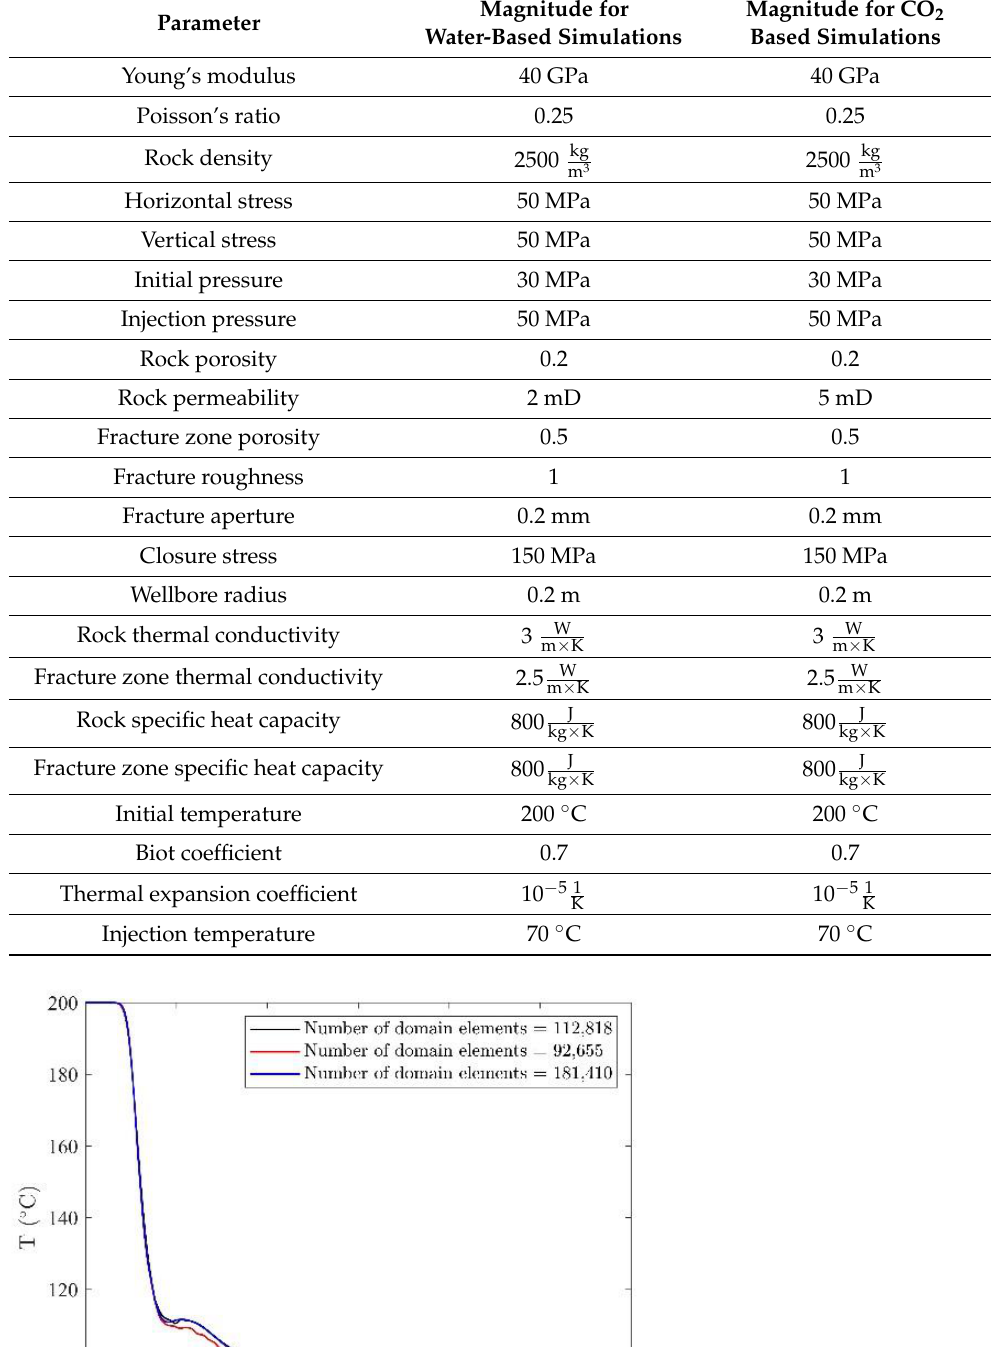
Table 1. Numerical simulation parameters (see the range of database in [48]).